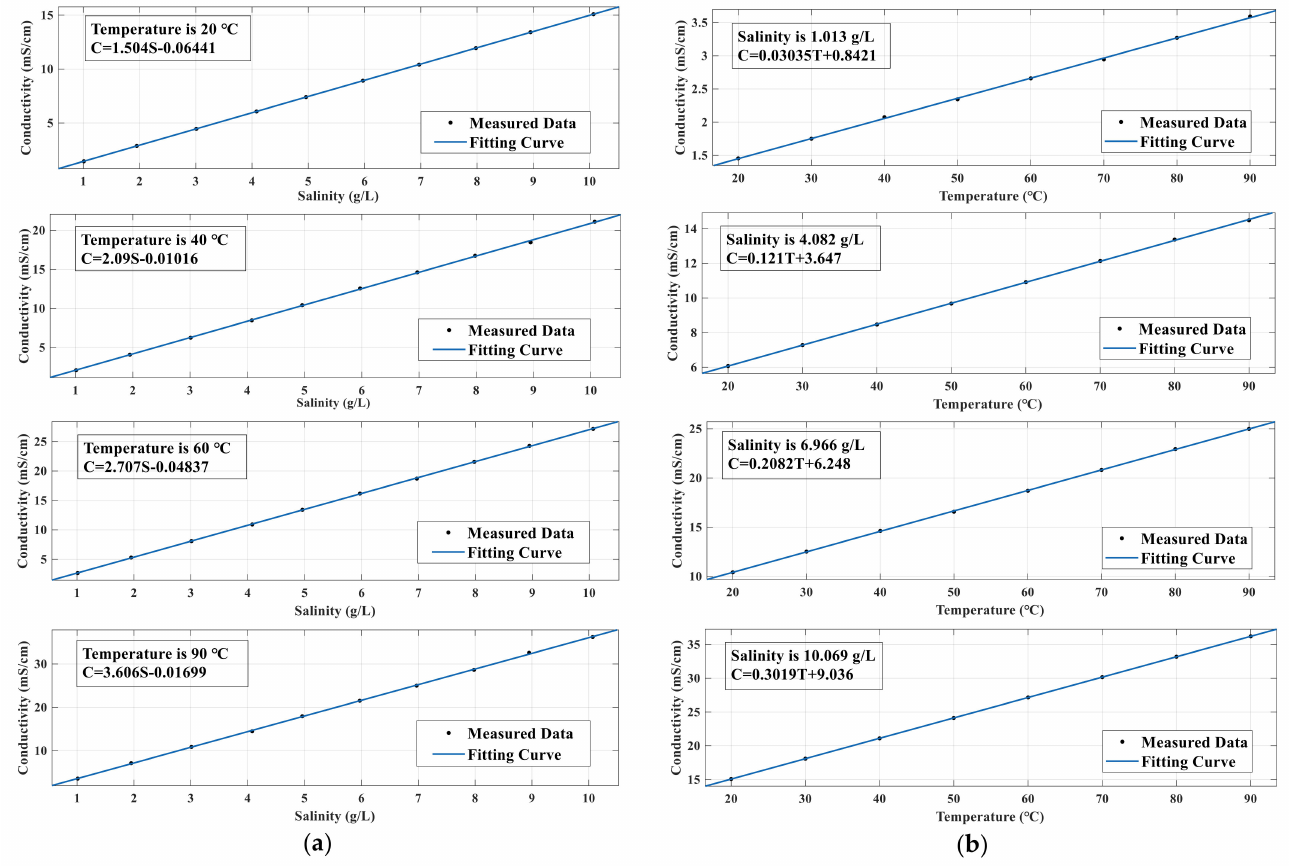
Figure 17. All other conditions held constant: the relationship between different salinity, temperature, and electrical conductivity. ( a ) Relationship between different salinity conditions and electrical conductivity at 20, 40, 60, and 90 ◦ C. ( b ) Relationship between temperature and conductivity under the salinity conditions of 1.013 g/L, 4.082 g/L, 6.966 g/L, and 10.069 g/L.